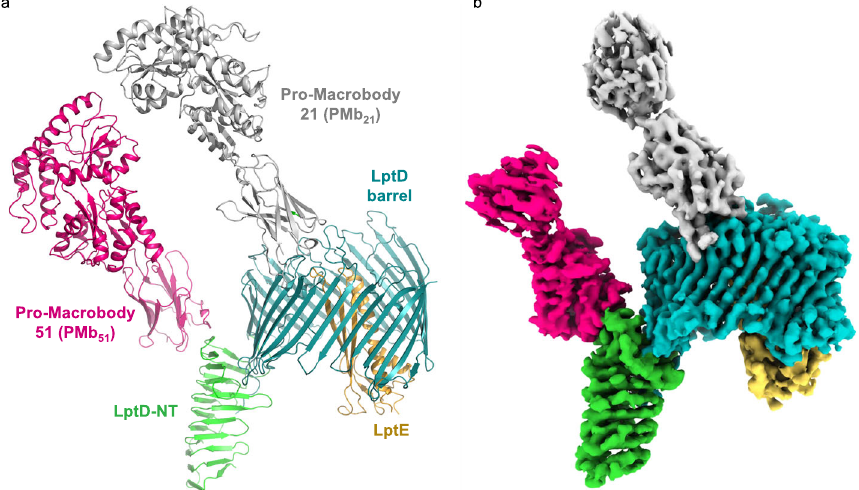
Fig. 1 Cryo-EM structure of the NgLptDE – PMb 21 /PMb 51 complex. a Side view of the NgLptDE – PMb 21 /PMb 51 complex. b Cryo-EM map of the NgLptDE – PMb 21 /PMb 51 complex at 3.4 Å. Colors encode domains as in ( a ).